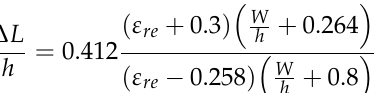
Table 1. Dimensional parameters of the proposed sensor.